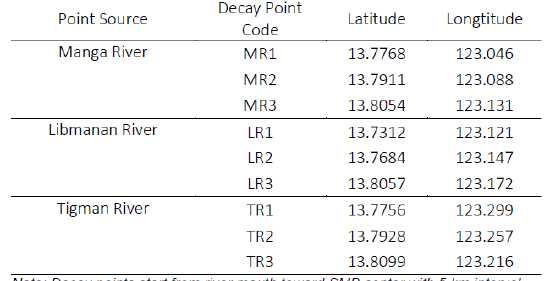
Table 2 . Decay Point Source and Code details